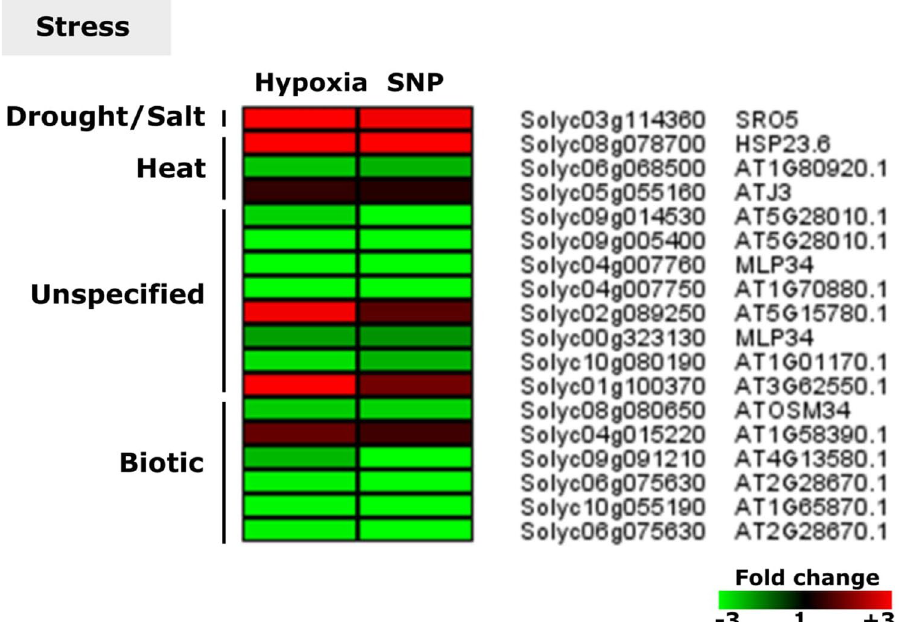
Figure 10. Expression pattern of biotic and abiotic stress related genes. Heat map represents the up-regulated (red bars) or down-regulated (green bars) tomato genes and their Arabidopsis thaliana homologs in response to hypoxia and SNP-treatment. Depicted are differentially expressed genes ( Padj < 0.05), ( n = 3). SRO5 , SIMILAR TO RCD ONE 5 ; HSP23.6 , MITOCHONDRION-LOCALIZED SMALL HEAT SHOCK PROTEIN 23.6 ; ATJ3 , DNAJ HOMOLOGUE 3 ; MLP34 , MLP-LIKE PROTEIN 34 ; OSM34 , OSMOTIN 34 .